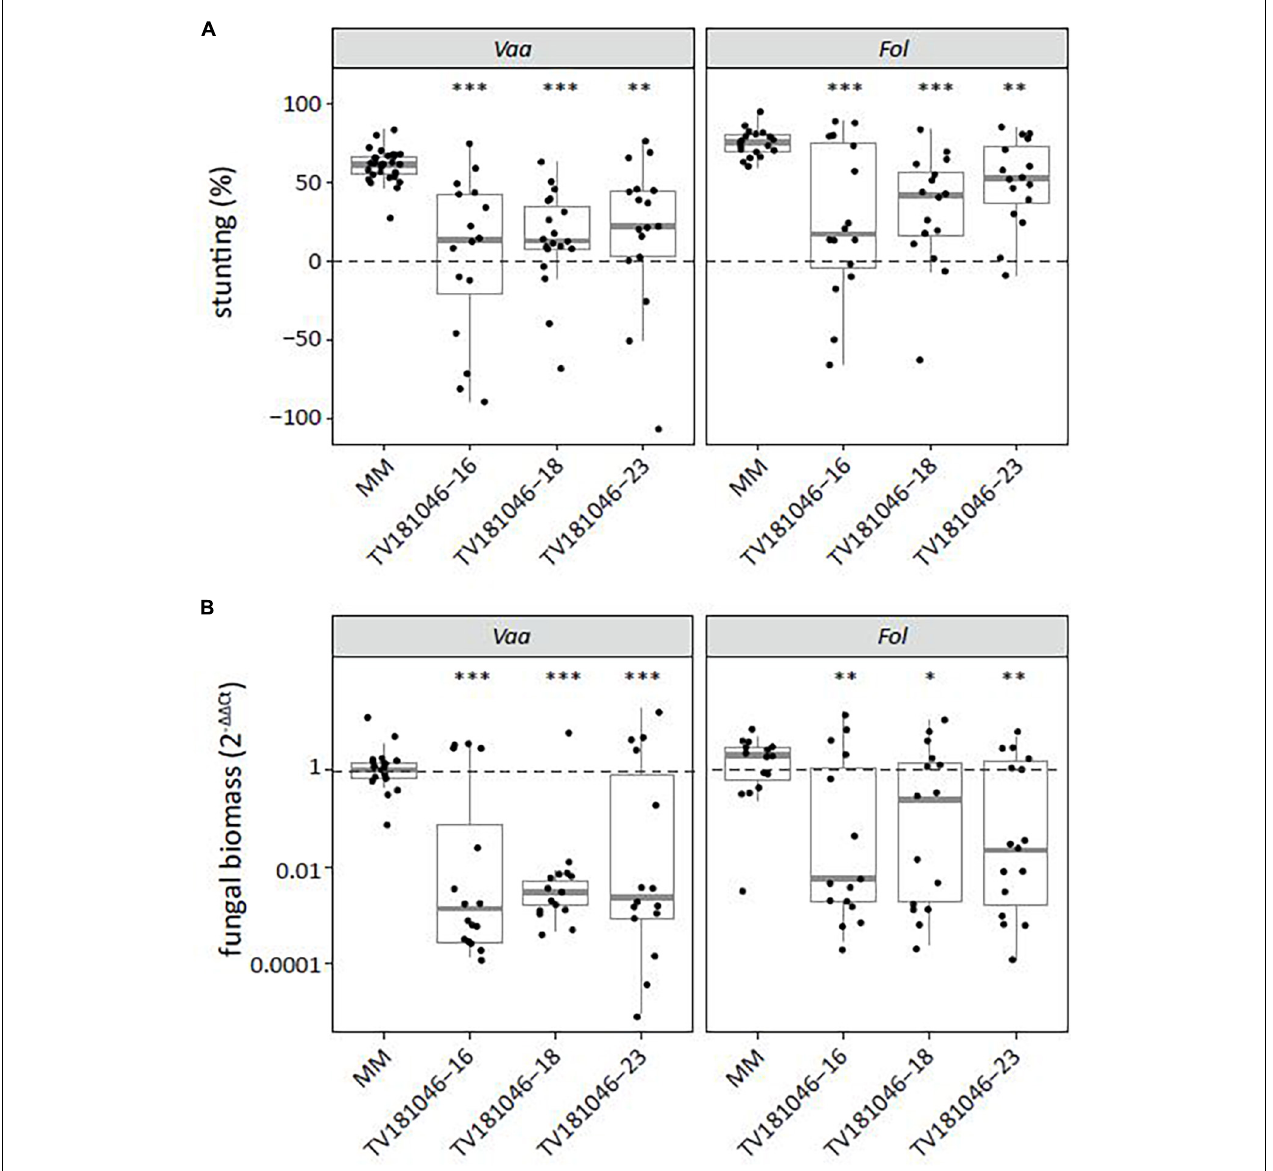
FIGURE 7 | Knockout of SlWAT1 lead to loss-of-susceptibility to V. albo-atrum and Fusarium oxysporum f. sp. lycopersici. (A) Stunting (%) of V. albo-atrum ( Vaa ) and F. oxysporum f. sp. lycopersici ( Fol ) inoculated T3 plants when compared with the average stunting of mock-inoculated plants at 21 days post inoculation (dpi). Box plots represent data with n ≥ 7 plants per experimental repeat ( t -test when compared with MM with ∗∗ p < 0.01 and ∗∗∗ p < 0.001). (B) Fungal biomass of Vaa- and Fol- inoculated T3 CRISPR plants at 21 dpi. This was determined on genomic DNA targeting the ITS gene ( Vaa and Fol ) relative to the tomato reference gene SlRUB ( Supplementary Table 1 ) and then normalized to Vaa and Fol inoculated MM plants using 2 − (cid:49)(cid:49) Ct on a log10 scale with n ≥ 7 per experimental repeat ( t -test on (cid:49) Ct when compared with MM with ∗ p < 0.05, ∗∗ p < 0.01, and ∗∗∗ p <